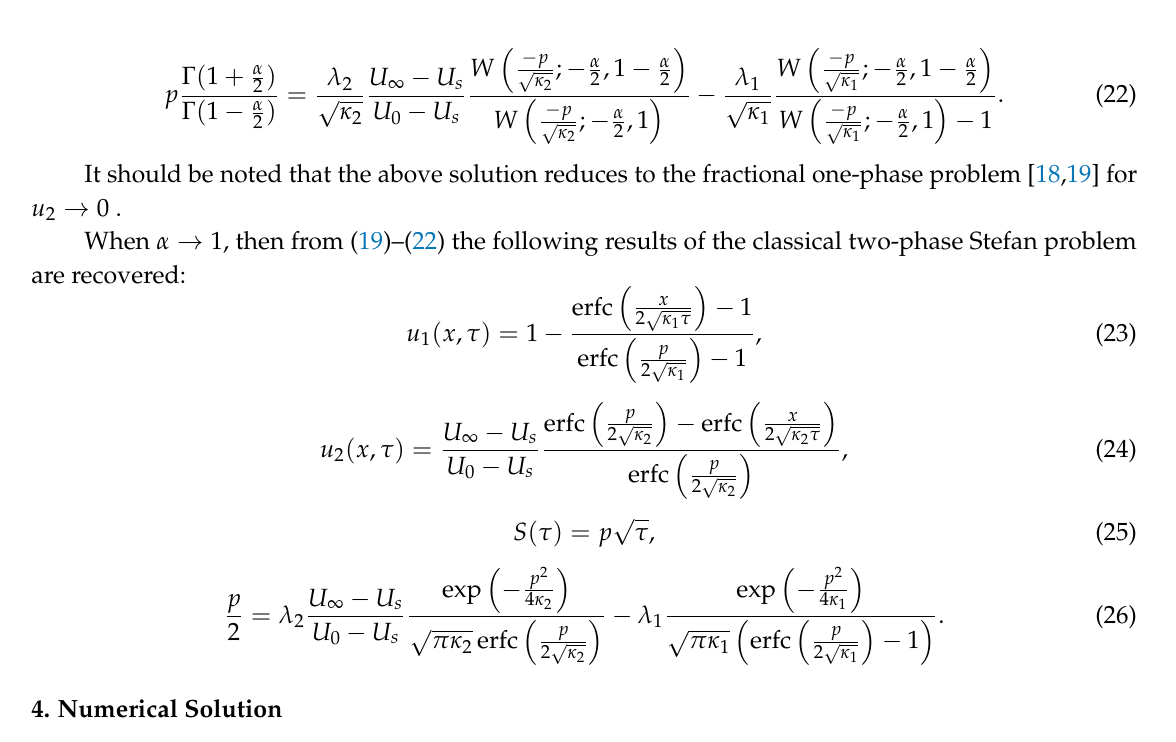
Figure 2. Meshes for α = 1, p = 1, m 1 = m 2 = 5, n = 5, l 2